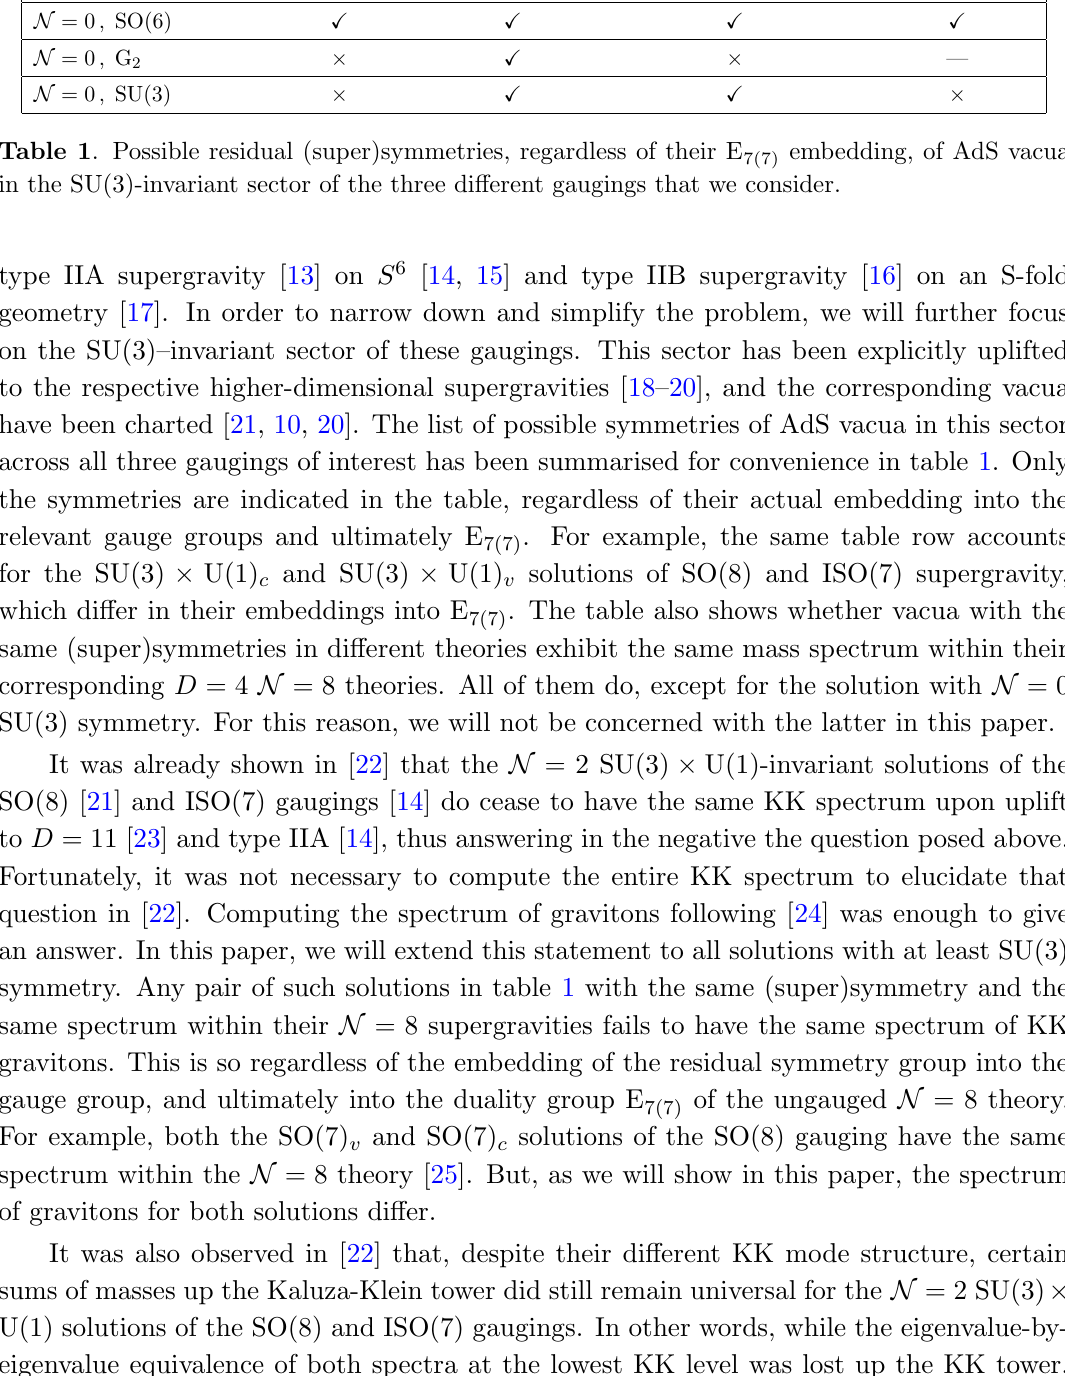
embedding, of AdS vacua 7(7)